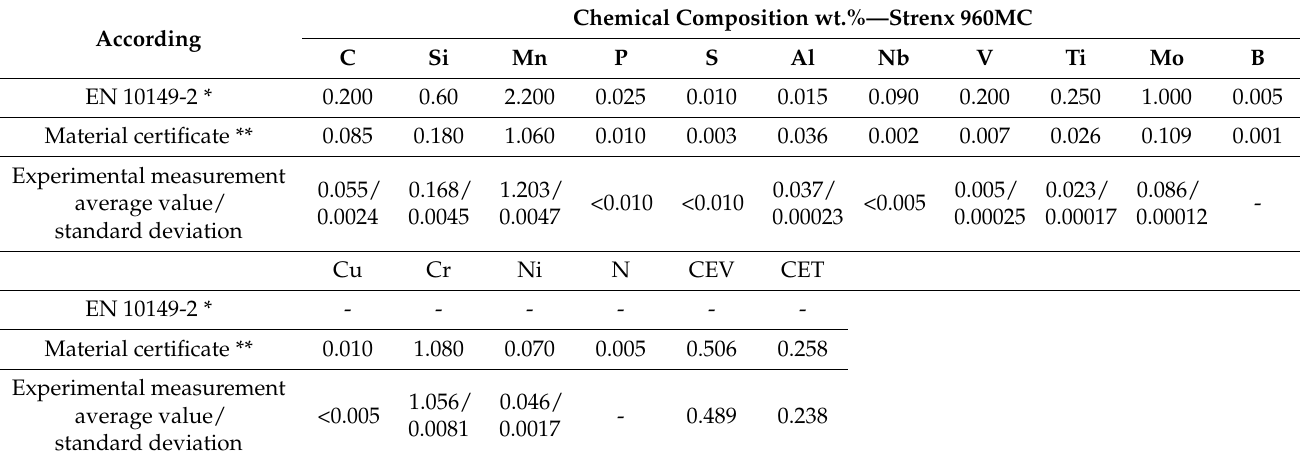
Table 1. Chemical composition of investigated steel.